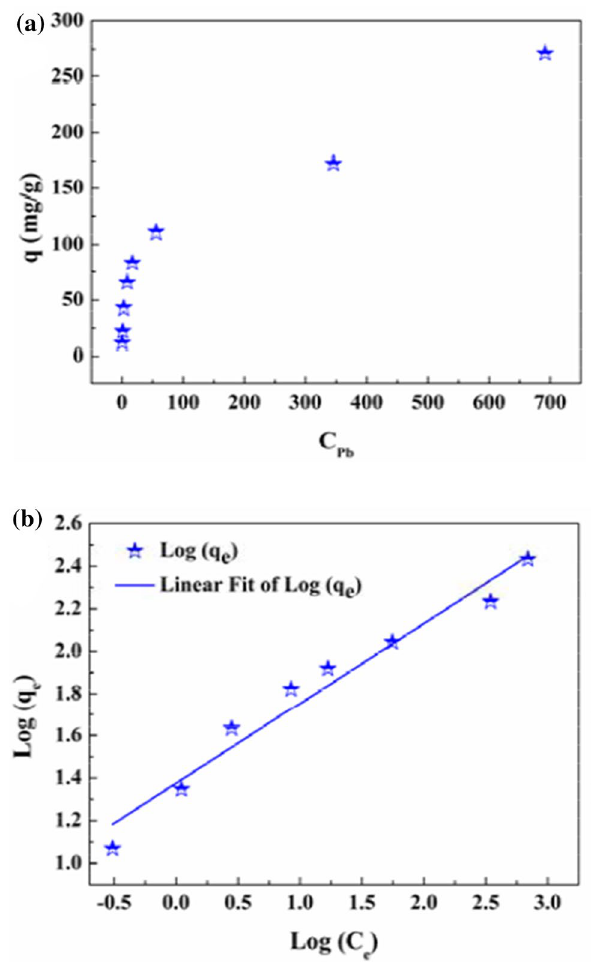
Fig. 6 The adsorption isotherm of Pb2 + on 3D AFC ( a ) and